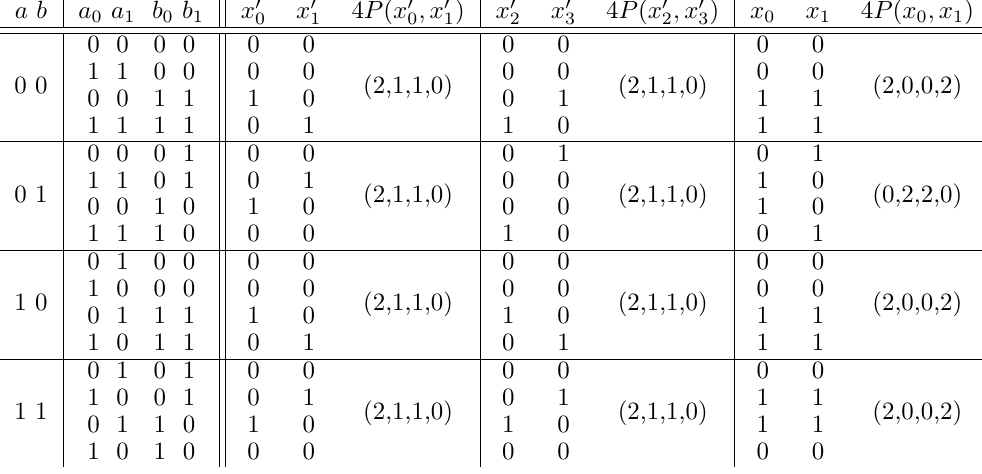
Table 1: Intermediate signals of Equation (2) for all possible input